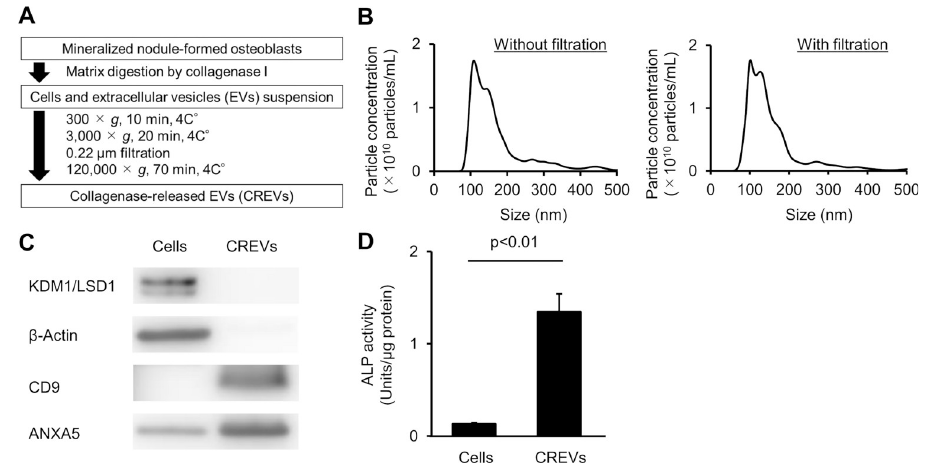
Fig 1. Analyses of collagenase-released extracellular vesicles isolated from mouse osteoblasts (CREVs). (A) A schema of a preparation of CREVs. (B) The particle size and concentration of CREVs in NanoSight meter analyses. Results are expressed as the mean of 5 measurements within one experiment in each group. (C) Western blotting analysis of KDM1/LSD1, β -actin, CD9, and Annexin A5 (ANXA5) in mouse osteoblast cell lysates and CREVs. (D) ALP activities of mouse osteoblast cell lysates and CREVs. Results are expressed as the mean ± SEM of 4 independent experiments. Statistical analyses were performed using the unpaired t -test.